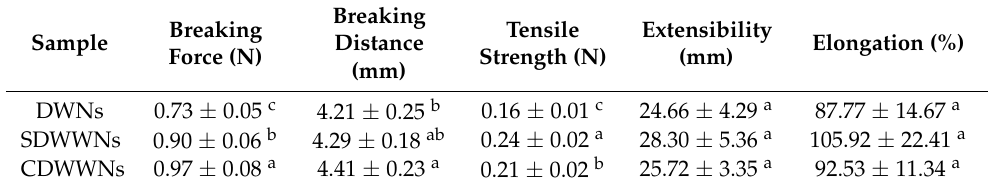
Table 2. Bending properties of the raw noodles and the tensile properties of the cooked noodles.